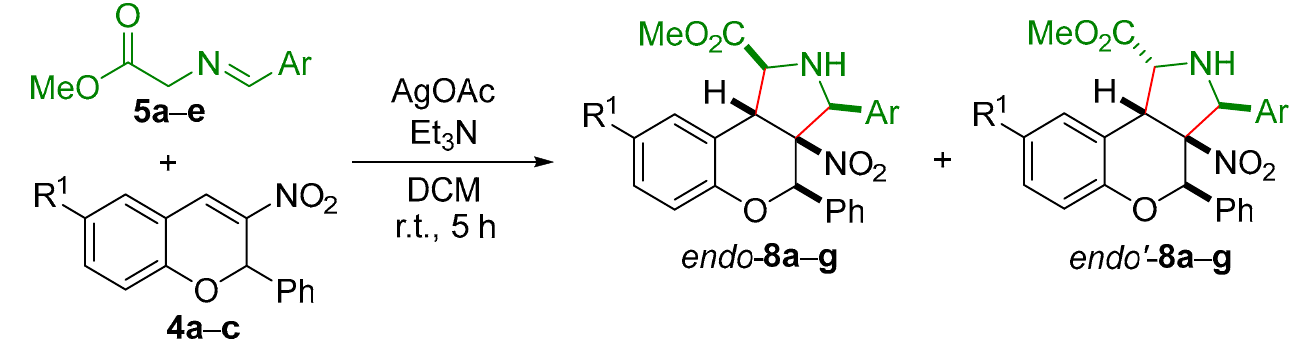
Scheme 4. Synthesis of 4-Ph-substituted chromeno[3,4- c ]pyrrolidines 8 .